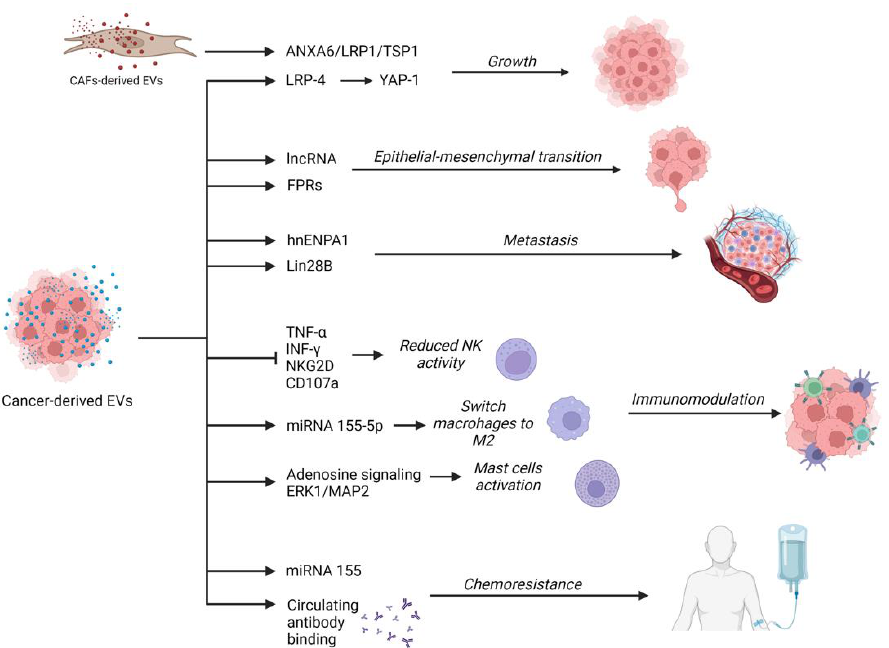
Figure 2. Roles of cancer-derived extracellular vesicles in pancreatic carcinogenesis, progression, and chemoresistance. Created with BioRender.com.